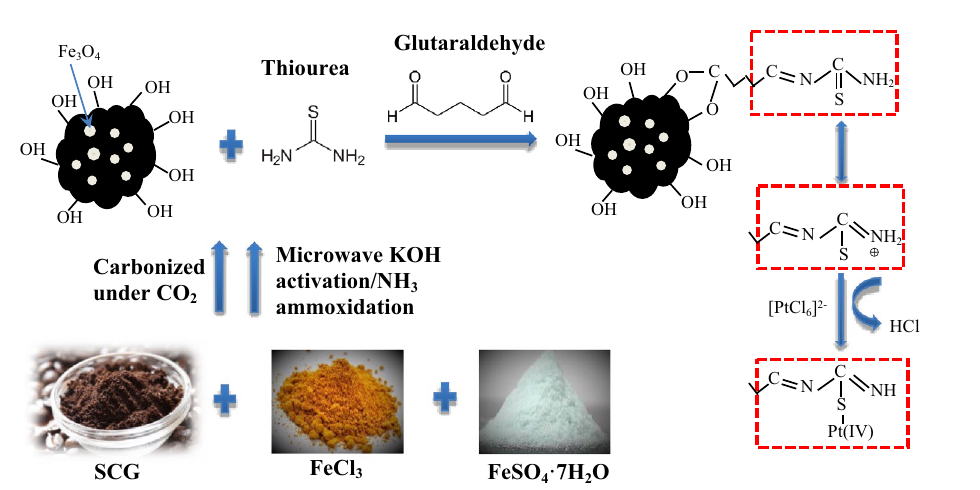
Figure 8. Proposed adsorption mechanism of Pt(IV) onto